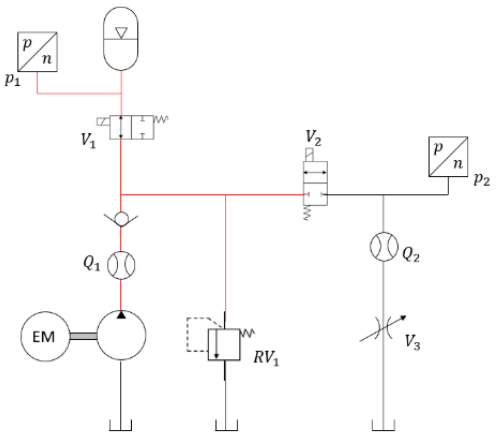
Figure 4. Hydraulic test bench during charging mode.